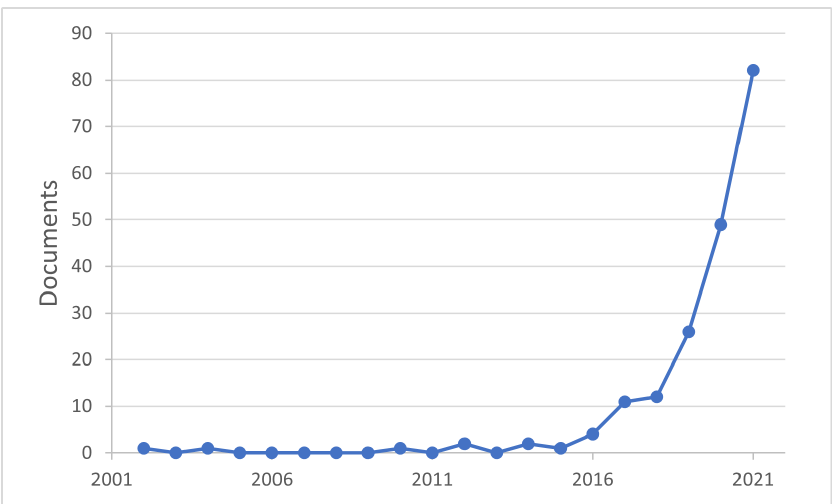
Figure 1. Evolution of scientific publications by